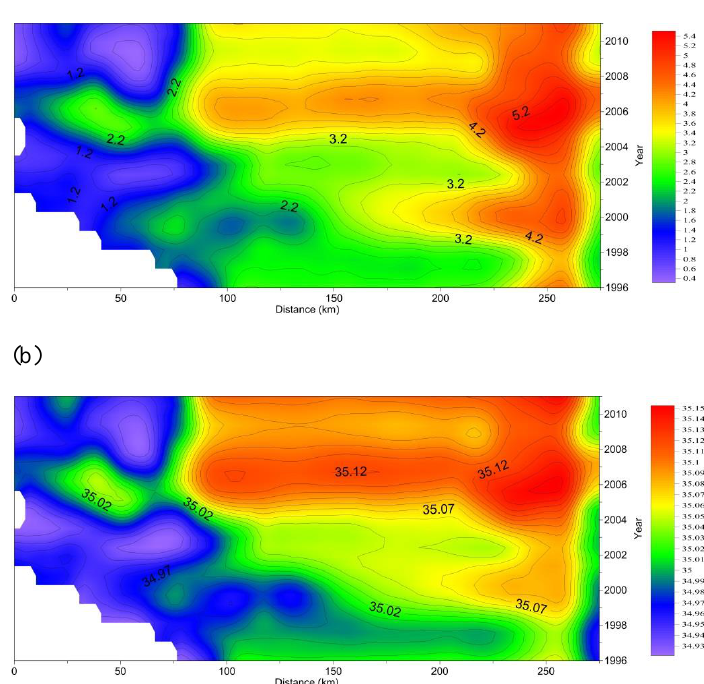
Figure 18. Section ‘N’ along the 76°30’ N. Hovmoeller diagram of the (a) temperature and (b) 5 Fig. 18. Section “N” along the 76 ◦ 30 0 N. Hovmoeller diagram of the (a) temperature and (b) salinity at 200dbar. salinity at 200 dbar. 6